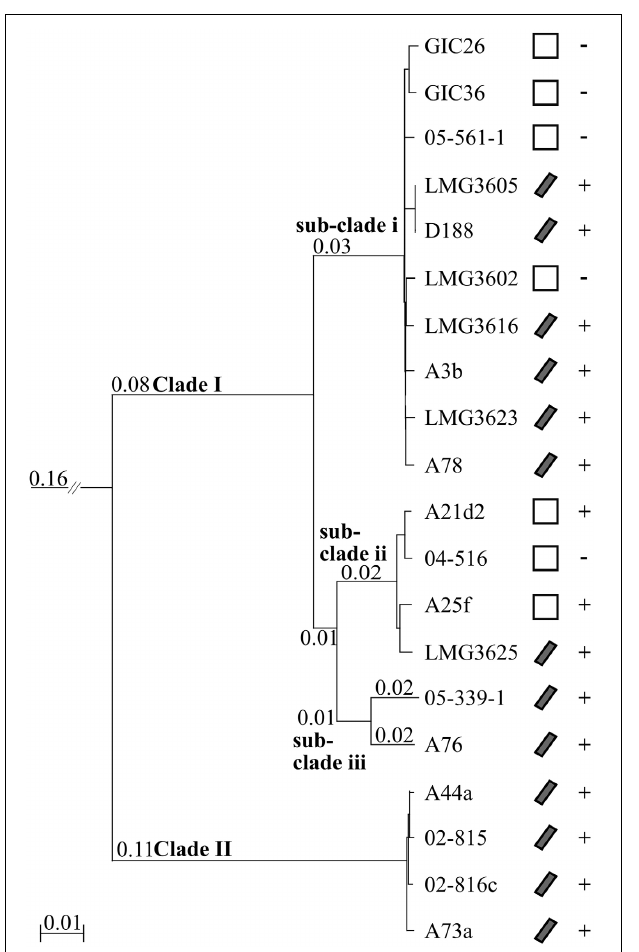
FIGURE 1 | Neighbor-joining tree based on 1727 homologous genes. A rooted neighbor-joining tree was constructed using translated sequences from 1727 genes present in all 20 isolates and the Nocardia farcinica type strain (not shown). Clade and sub-clade designations are indicated at the corresponding node. Scale bar, number of amino acid substitutions per site; only branches with lengths greater than zero are indicated. Isolates with a linear plasmid are denoted with a diagonal bar; empty boxes, absence of linear plasmid. Phytopathogenic isolates are indicated with, “ + ”; non-pathogenic isolates are indicated with, “ − .”